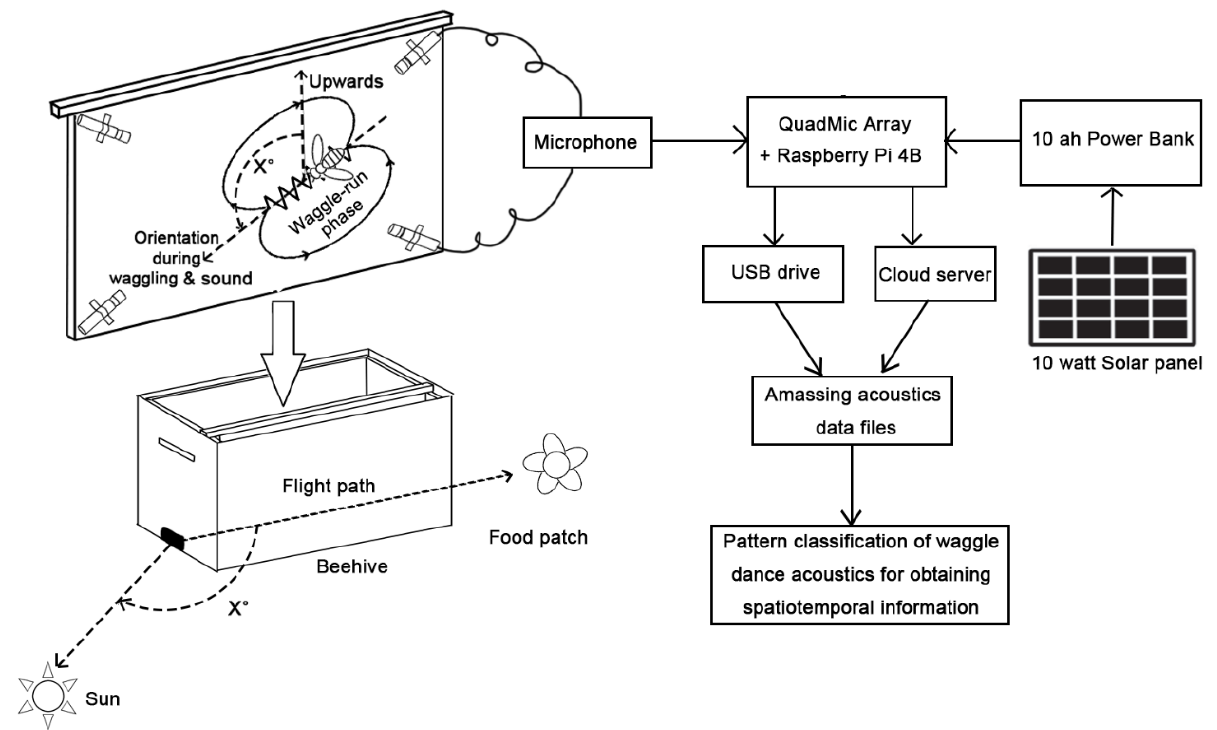
Figure 7. A proposed acoustics-recording setup installed within the hive to tape the sounds of different dancing bees (top left), steps to gather the massive acoustic dataset from these dances, and their analysis for pattern recognition for spatiotemporal information on the food-rich sources (right). In the sketch, there is shown an orientation of the dancing bee (top left), which represents the coordinates or spatial geometry of the food patch relative to the solar azimuth (down left). Temporal information (foraging distance from the hive to the food patch) is exhibited through the vibroacoustic activity of dancers during the waggle-run phase (top left).